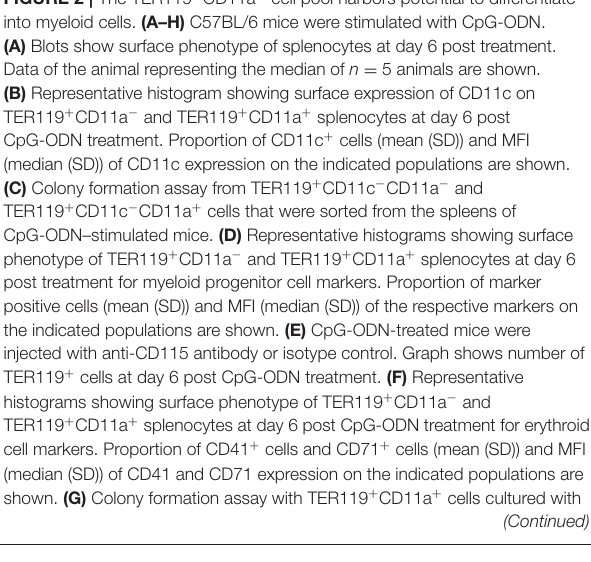
FIGURE 2 | The TER119 + CD11a + cell pool harbors potential to differentiate into myeloid cells. (A–H) C57BL/6 mice were stimulated with CpG-ODN. (A) Blots show surface phenotype of splenocytes at day 6 post treatment. Data of the animal representing the median of n = 5 animals are shown. (B) Representative histogram showing surface expression of CD11c on TER119 + CD11a − and TER119 + CD11a + splenocytes at day 6 post CpG-ODN treatment. Proportion of CD11c + cells (mean (SD)) and MFI (median (SD)) of CD11c expression on the indicated populations are shown. (C) Colony formation assay from TER119 + CD11c − CD11a − and TER119 + CD11c − CD11a + cells that were sorted from the spleens of CpG-ODN–stimulated mice. (D) Representative histograms showing surface phenotype of TER119 + CD11a − and TER119 + CD11a + splenocytes at day 6 post treatment for myeloid progenitor cell markers. Proportion of marker positive cells (mean (SD)) and MFI (median (SD)) of the respective markers on the indicated populations are shown. (E) CpG-ODN-treated mice were injected with anti-CD115 antibody or isotype control. Graph shows number of TER119 + cells at day 6 post CpG-ODN treatment. (F) Representative histograms showing surface phenotype of TER119 + CD11a − and TER119 + CD11a + splenocytes at day 6 post CpG-ODN treatment for erythroid cell markers. Proportion of CD41 + cells and CD71 + cells (mean (SD)) and MFI (median (SD)) of CD41 and CD71 expression on the indicated populations are shown. (G) Colony formation assay with TER119 + CD11a + cells cultured with